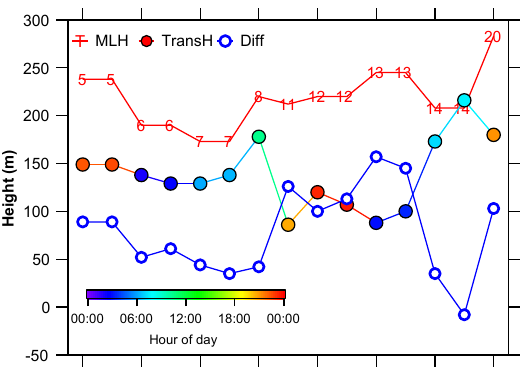
Figure 11. A comparison of mixing layer height (MLH) with that estimated from the transition heights of b ext . The numbers of ver- tical profiles as marked in Fig. 1 and the differences of the two heights are also shown. Note that only vertical profiles with sig- nificant changes were used for estimation of transition